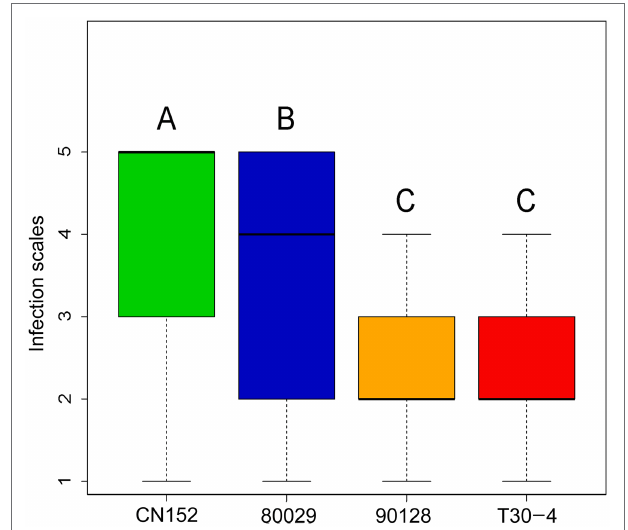
FIGURE 1 | Post-hoc analysis of late blight scores among Phytophthora infestans isolates. Bars labeled with a different capital letter at the top of each parameter show a significant difference at p <